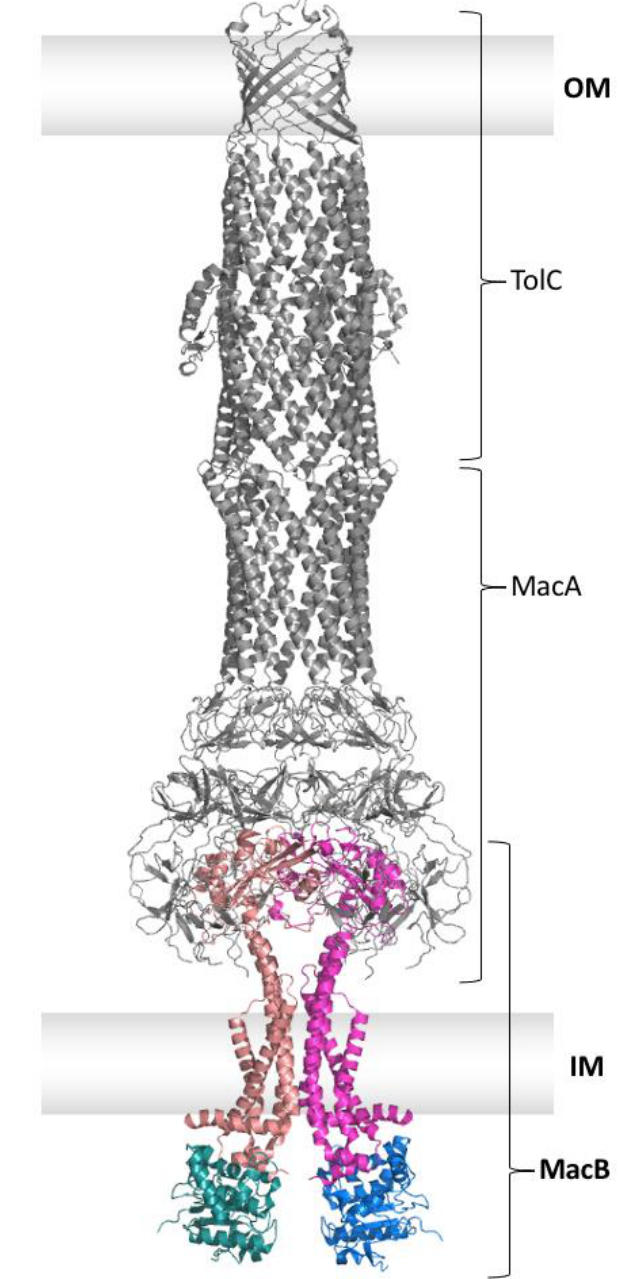
Figure 4. Single particle cryo-EM structure of the assembled MacAB-TolC efflux system (PDB entry 5NIL). Trimeric TolC and hexameric MacA are shown in grey and dimeric MacB in color. The nucleotide-binding domains of MacB are shown in deep teal and marine, and the transmembrane domains, plus the periplasmic part, are shown in salmon and light magenta. The outer membrane (OM) and inner membrane (IM) are displayed as grey boxes. The peptidoglycan layer is omitted for reasons of clarity.